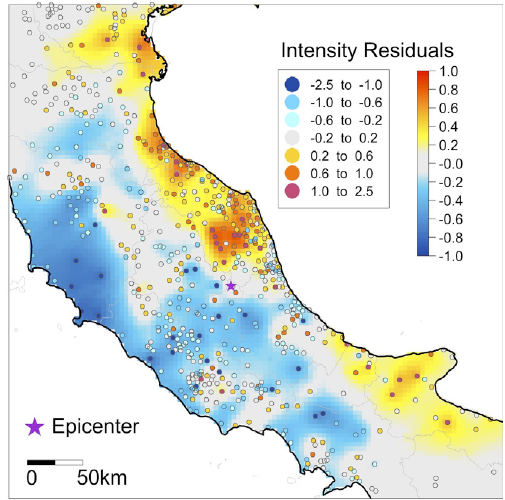
Figure 4. Intensity residual values (coloured dots) and the anisotropic component field (I eas) interpolated by using the block Kriging